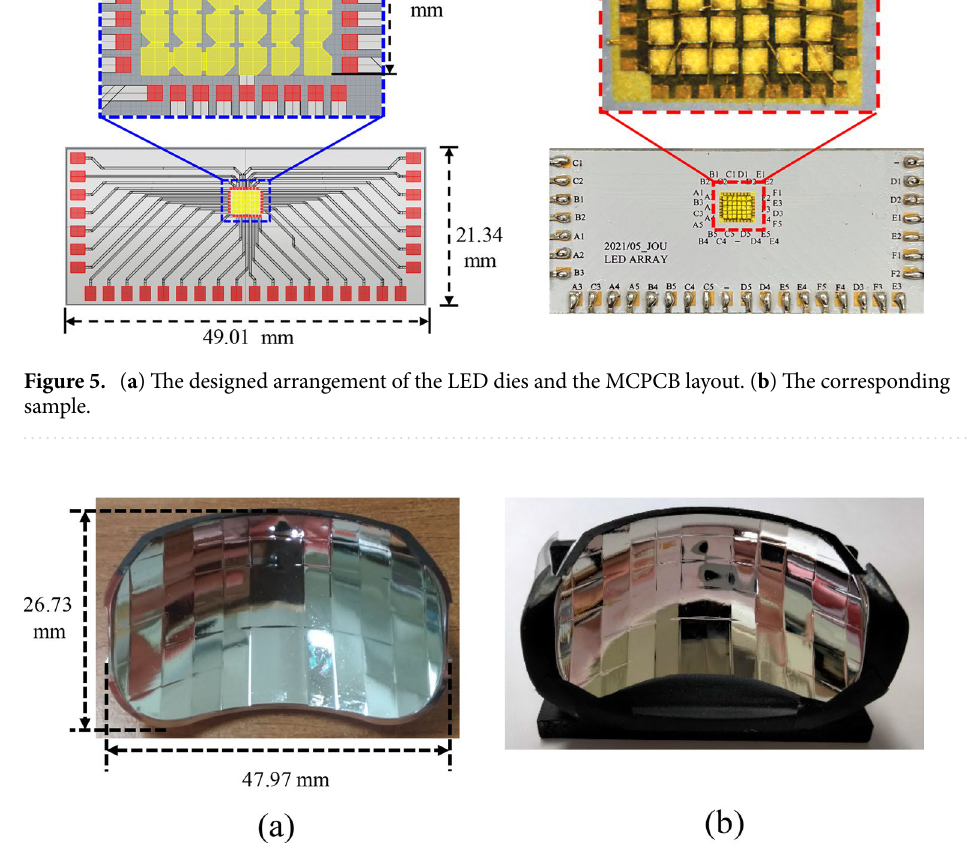
Figure 6. ( a ) The sample of the designed reflector, and ( b ) with a holder in the